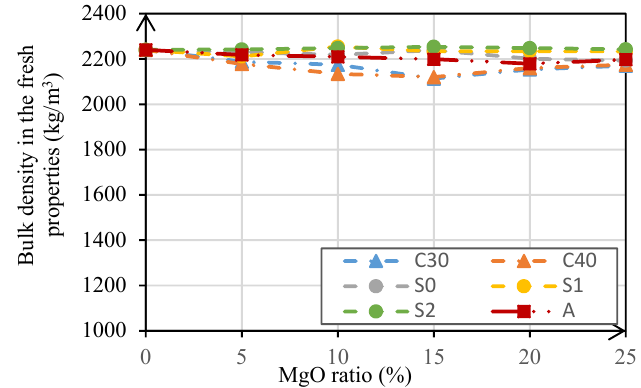
Figure 3. Mortar bulk density as a function of the MgO content.